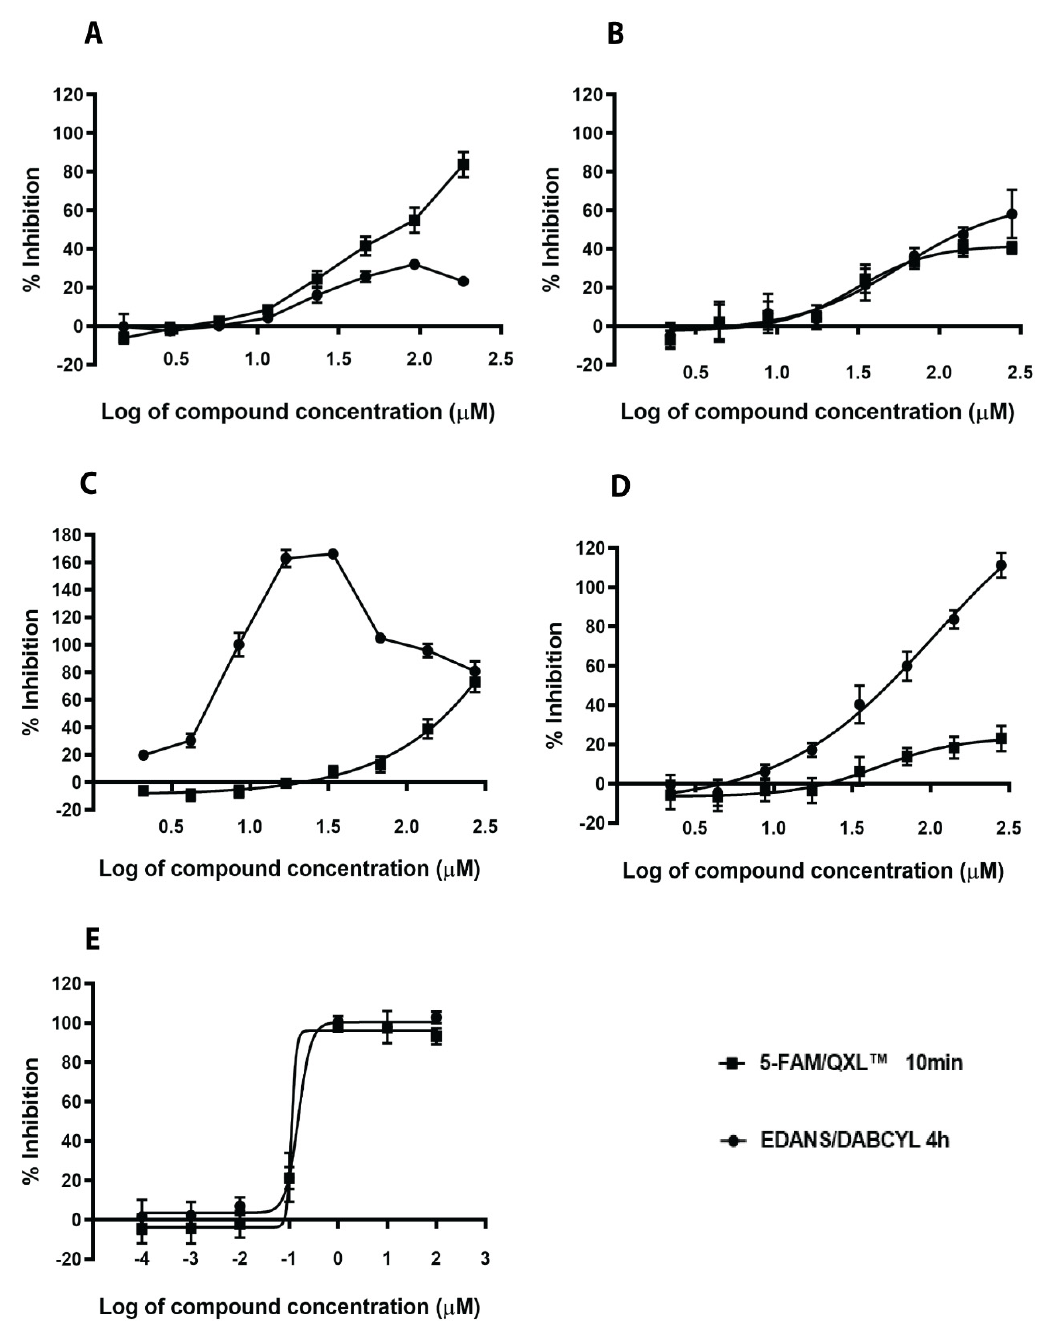
Figure 2. Dose response of hit compounds and known inhibitors on sortase A. Inhibition of Sortase A (SrtA) activity was measured at 10 min or 4 h using two sortase A substrates. N1287 ( A ), N2576 ( B ), curcumin ( C ), chlorogenic acid ( D ) and p-HMB ( E ). The results are mean values and SE of three replicates.